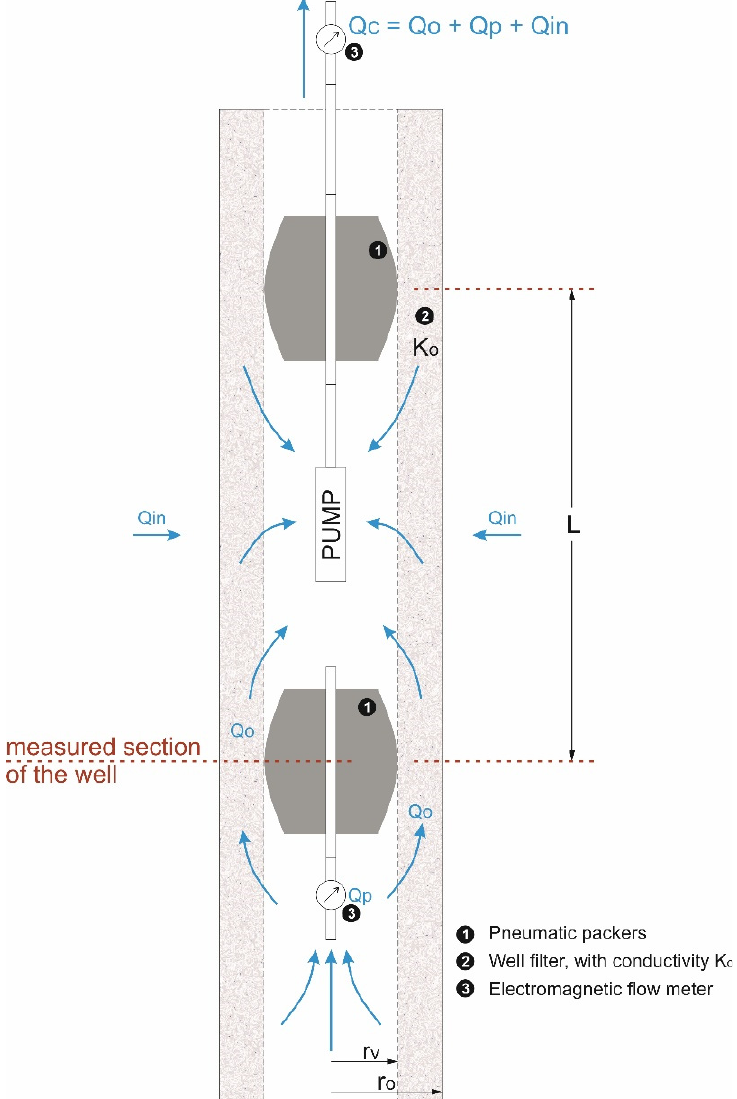
Figure 1. Conceptual diagram of the INV-FLOW apparatus.